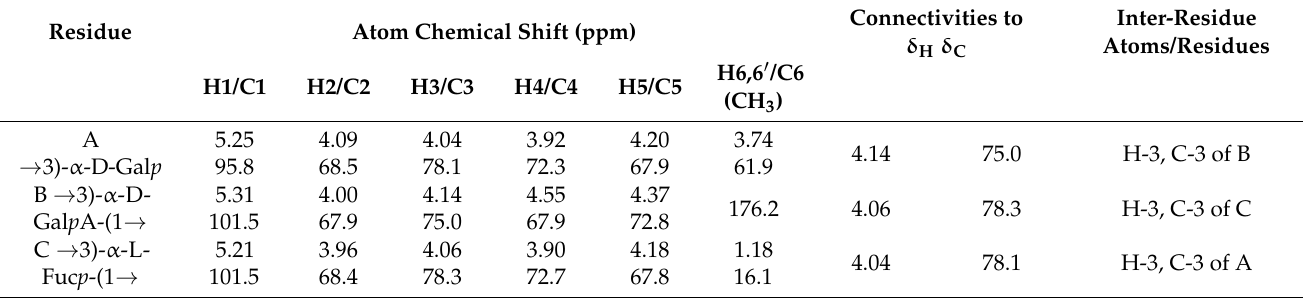
Table 2. 1 H and 13 C NMR chemical shifts and sugar connectivities of CPS K63 isolated from K. pneumoniae Kp486 a